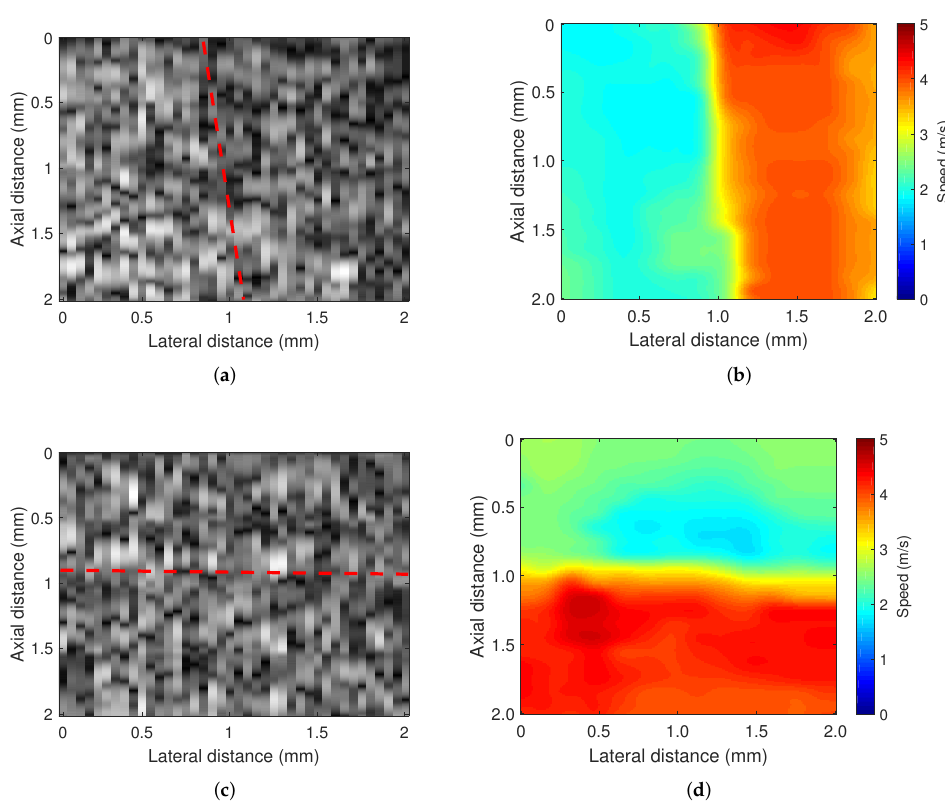
Figure 4. B-mode image and its corresponding wave speed image for heterogeneous phantoms. The red dotted line indicates the boundary between two phantoms. ( a ) B-mode image: side by side phantom, ( b ) elastography: side by side phantom, ( c ) B-mode image: layered phantom, and ( d ) elastography: layered phantom.